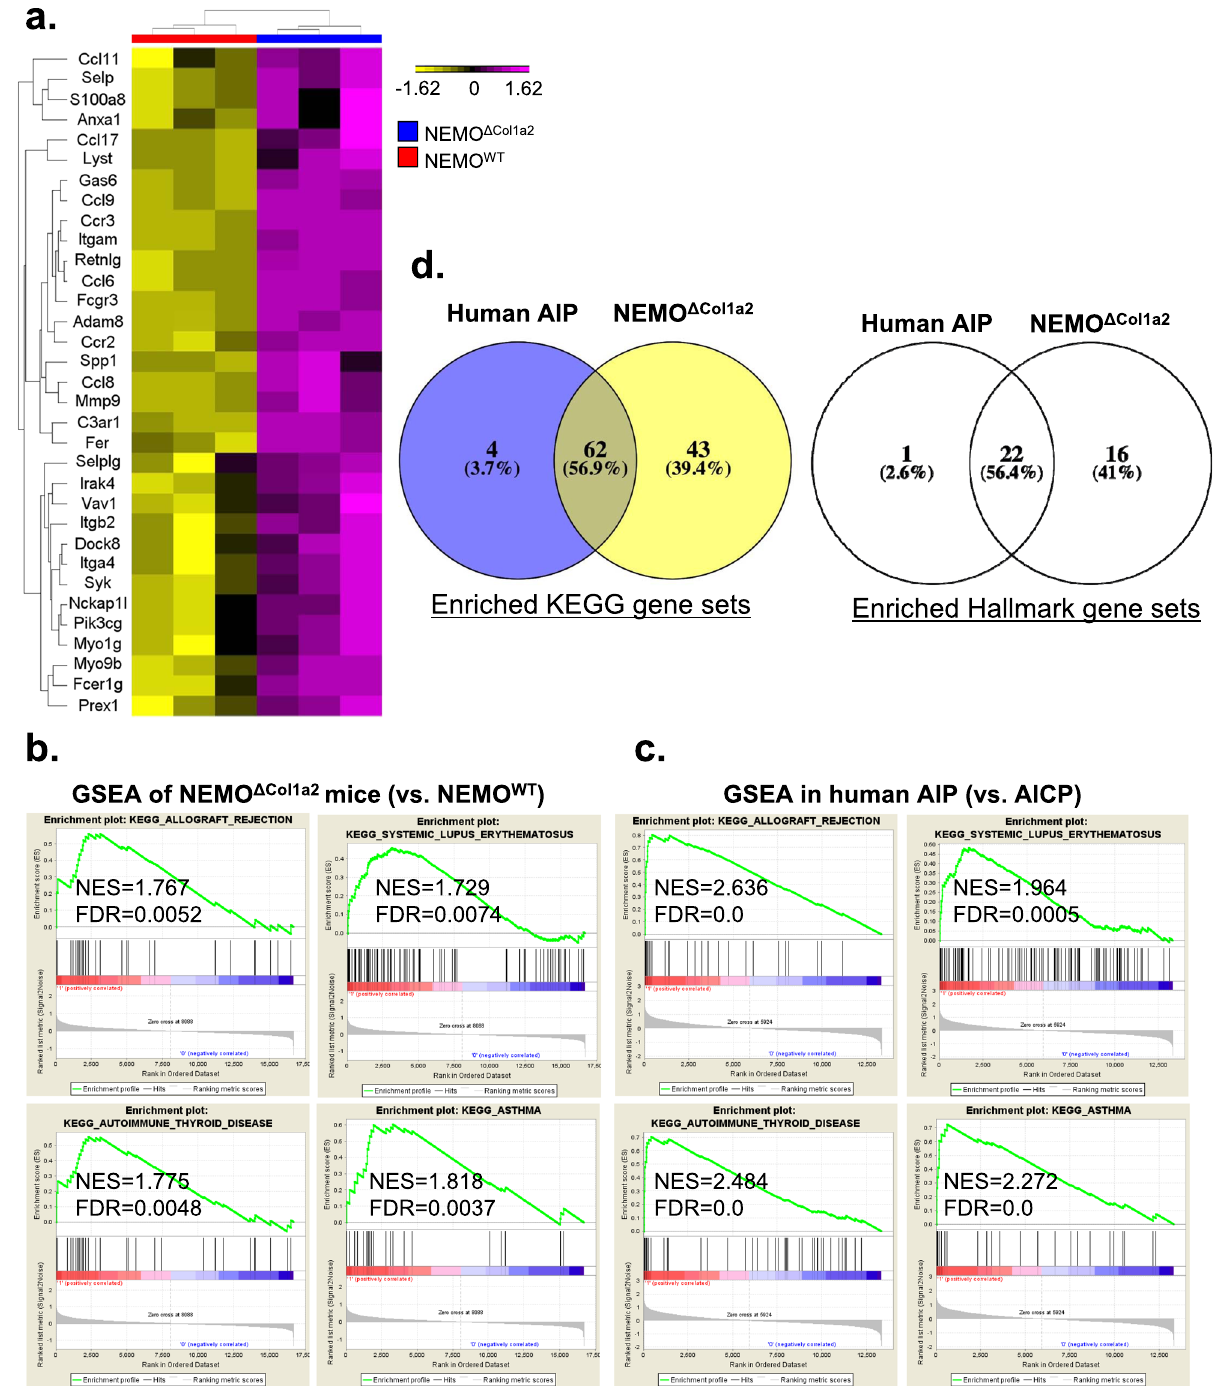
Fig. 6 Enrichment of autoimmune gene signatures in NEMO Δ Col1a2 pancreata resembling the AIP patients. DNA microarray performed on pancreatic samples from NEMO WT and NEMO Δ Col1a2 mice from the 3-week time point. a Heatmap illustrating genes from the “ GO Leukocyte Migration ” gene set. b GSEA performed on the microarray results from the pancreatic samples of NEMO Δ Col1a2 and NEMO WT mice ( n = 3). c GSEA analysis of microarray data from AIP patients ( n = 4) using AlCP patients ( n = 5) as a reference. d Venn diagrams showing the common GSEA enriched gene sets from the KEGG and Hallmark gene set database (FDR ≤ 0.25). NES Net enrichment score, FDR False discovery rate. All n numbers represent biological PSC Δ NEMO cells promote eosinophilia through the secretion of CD45 (Fig. 8a). All cells had a fi broblastoid morphology and CCL24 . To analyze the molecular changes within PSCs after expressed nestin, another marker of PSCs, in culture (Fig. 8b, c). NEMO deletion (PSC Δ NEMO ), we isolated PSCs at the 3-week Quanti fi cation of RFP expression indicated that 56% of these time point after caerulein and tamoxifen injections. To access cells were nestin + /RFP + . Deletion of NEMO was con fi rmed at mRNA and protein levels, with PSC Δ NEMO cells showing 76% the purity of the cell fraction, we stained the cells and found and 92% reduction respectively (Fig. 8d, e). Thus, it appears that all isolated cells showed vimentin expression but absence of